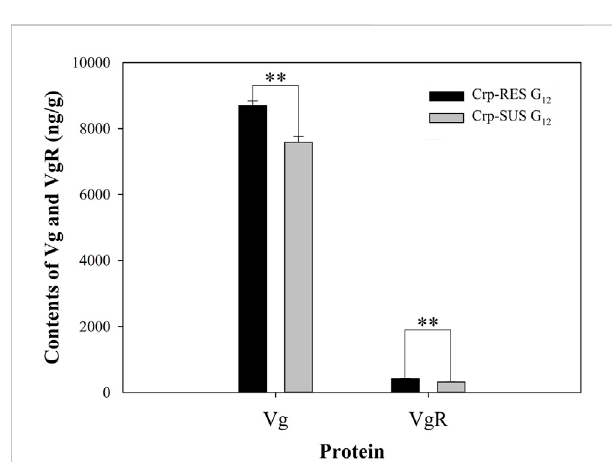
FIGURE 5 Contents of Vg and VgR for Crp-RES G 12 and Crp-SUS G 12 strains were presented as the mean of three replications ± SE. The asterisks above the bars indicate statistical differences between Vg and VgR contents of both strains (Student ’ s t -test, ** p <